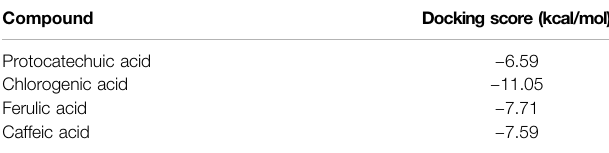
TABLE 1 | Docking score of GSK active site with phenolic